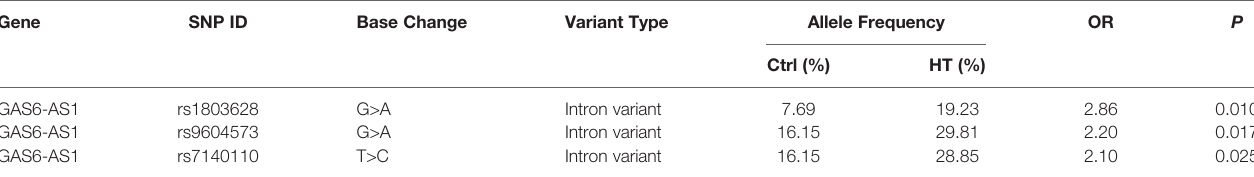
TABLE 4 | Association of GAS6 gene mutations and polymorphisms with hemorrhagic transformation. Gene SNP